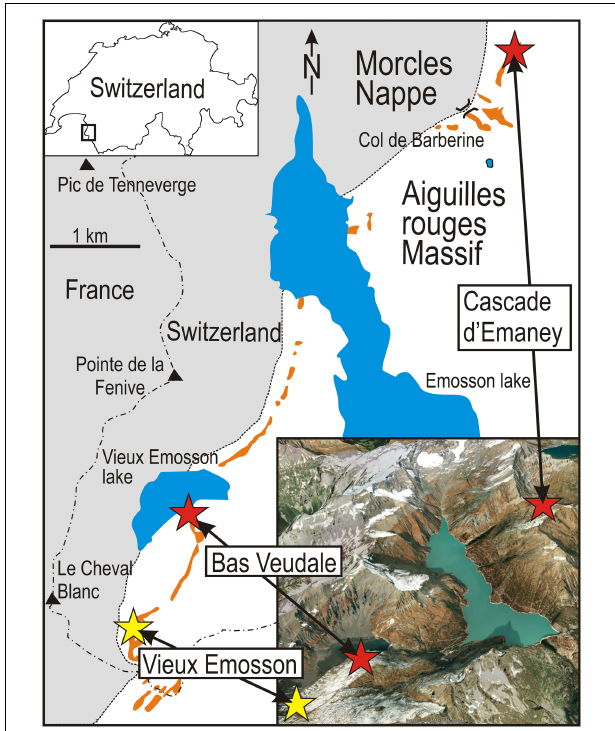
FIGURE 1 | Geographic and geological settings of the study area, with the location of the area within Switzerland (upper left box) and an inclined aerial view (Google Earth) showing the locations of the sites in topographic context (lower right box). Orange patches represent the sandstone outcrops of the Triassic. Studied sites are indicated by red stars and the historical site of Vieux Emosson is indicated by a yellow